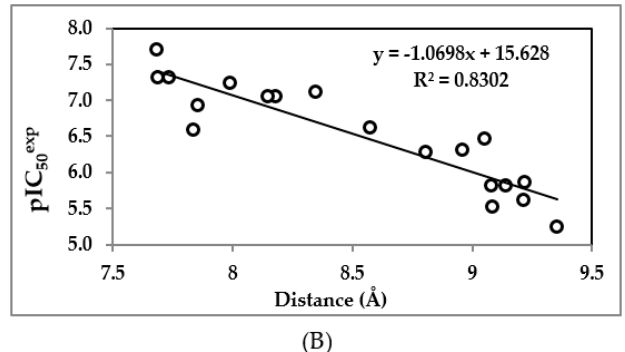
Figure 10. Molecular mechanics inter-molecular interaction energy E int break-down to active site residue contributions in [kcal.mol − 1 ]: ( A ) designed best five novel BHMB analogs (the color coding refers to ligands given in the legend), ( B ) correlation between p IC 50exp and distance from the benzamide carbonyl oxygen to the Arg43 warhead carbon atom (7.5–9.5 Å).